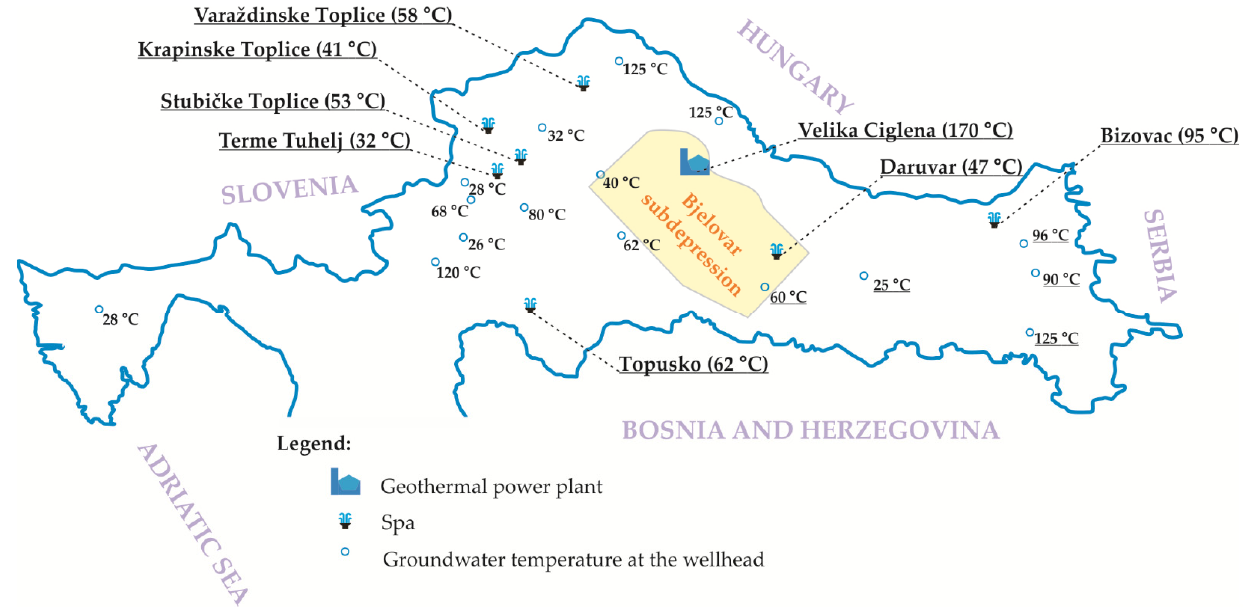
Figure 7. Temperature values in proven geothermal reservoirs modified after [25].